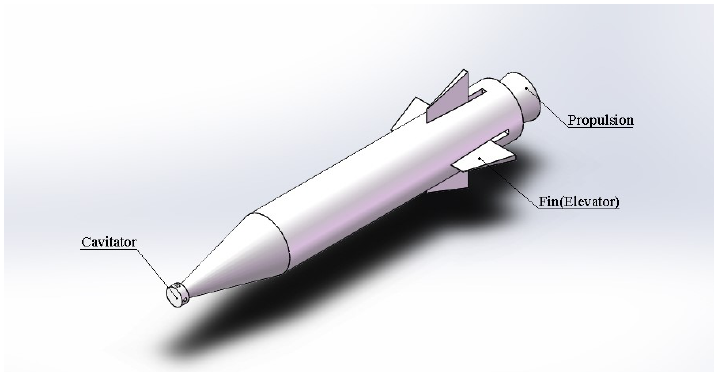
Figure 1. Schematic diagram of a supercavitating vehicles